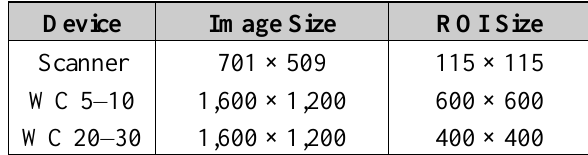
Table 3. Mean resolution (pixels) of hand images and palm print ROI of the proposed devices.